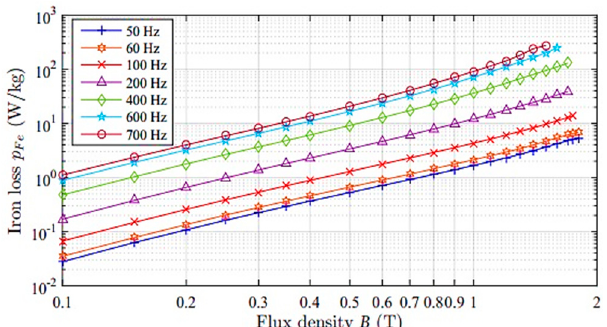
Figure 1. Comparison of five coefficients institute of electrical machines formula (IEM-Formula) with measurements under 50 up to 700 (Hz) frequencies from the Epstein test, where solid lines denote analytical data and markers indicate measured data.